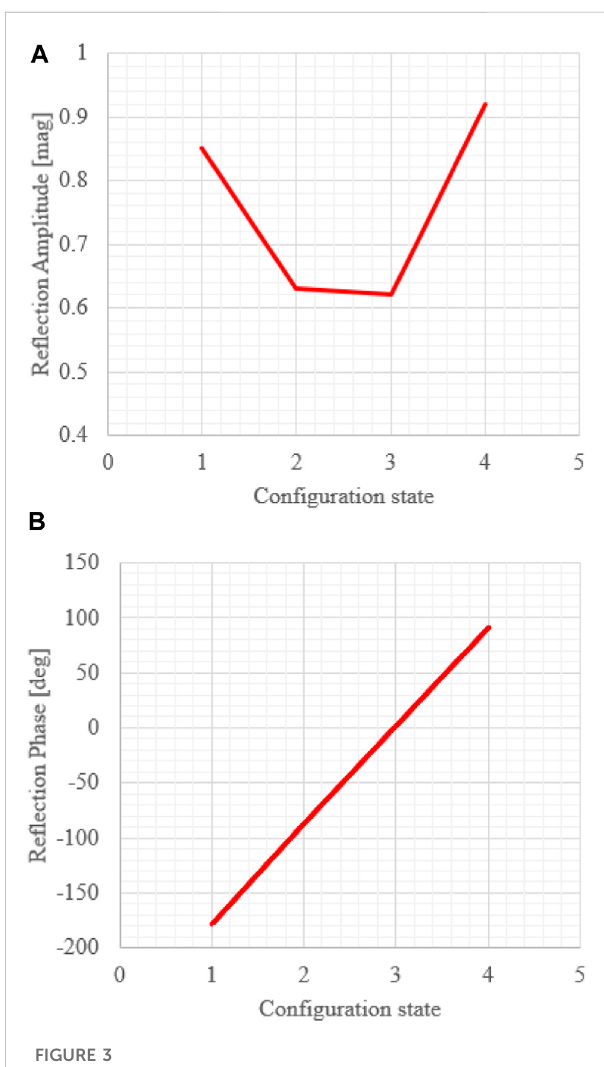
FIGURE 3 Unit cell con fi guration states at 24.5 GHz. (A) Re fl ection amplitude. (B) Re fl ection